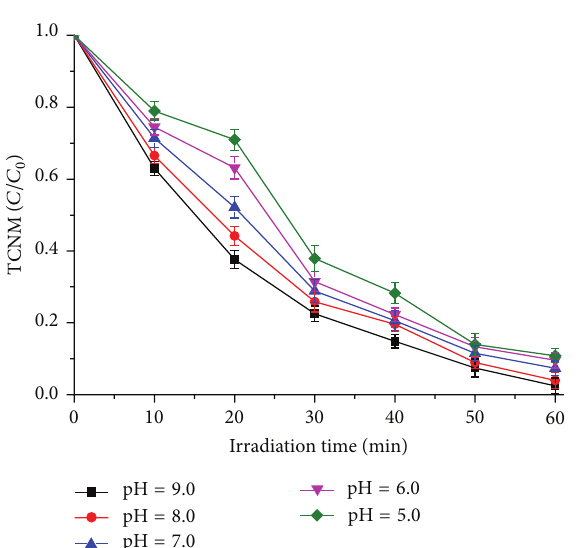
Figure 6: Effect of chloride ion on the photodegradation of